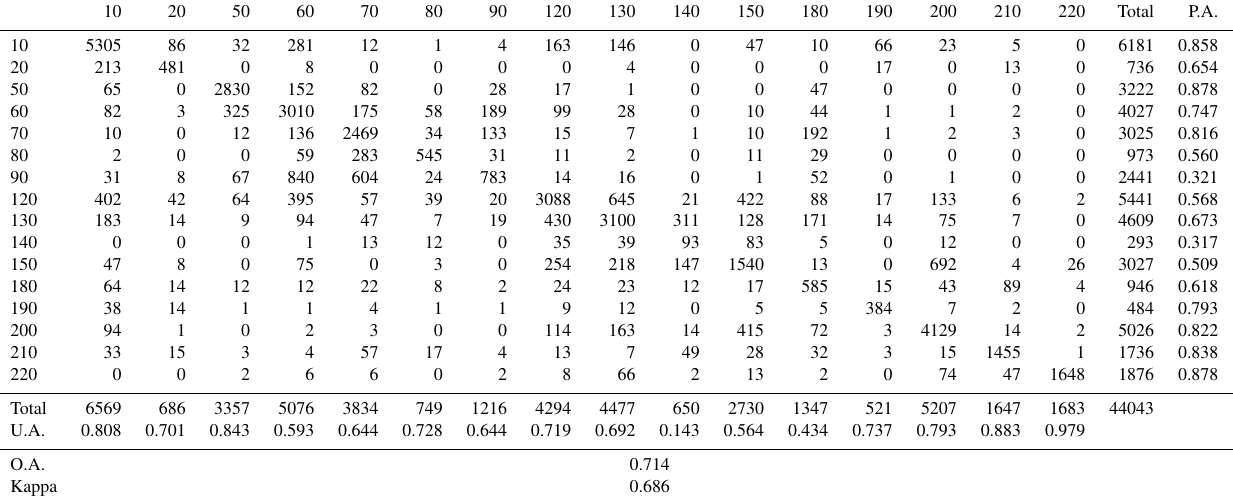
Table 4. The accuracy matrix for the GLC_FCS30-2015 land-cover product according to the LCCS level-1 validation